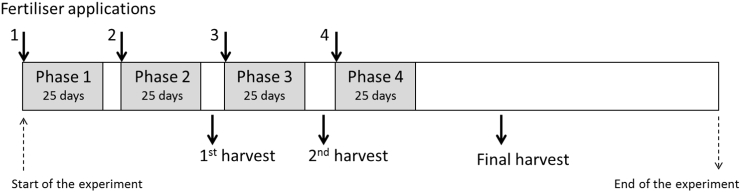
Time line for the experimental phases used for the analysis of the split application treatment. Duration of the phases have been normalised according to the shortest period between 2 fertiliser applications.